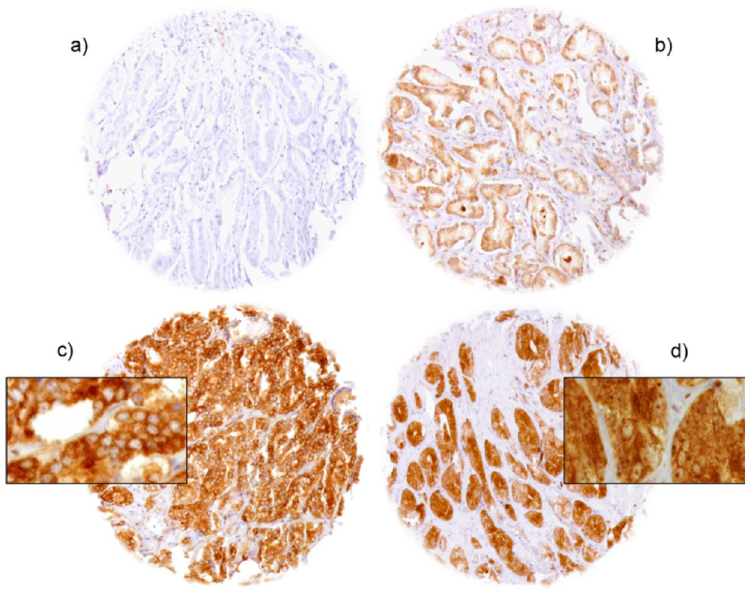
Figure 1. Representative pictures of YB-1 staining in prostate cancer with ( a ) negative, ( b ) moderate, ( c ) strong cytoplasmic staining and ( d ) nuclear